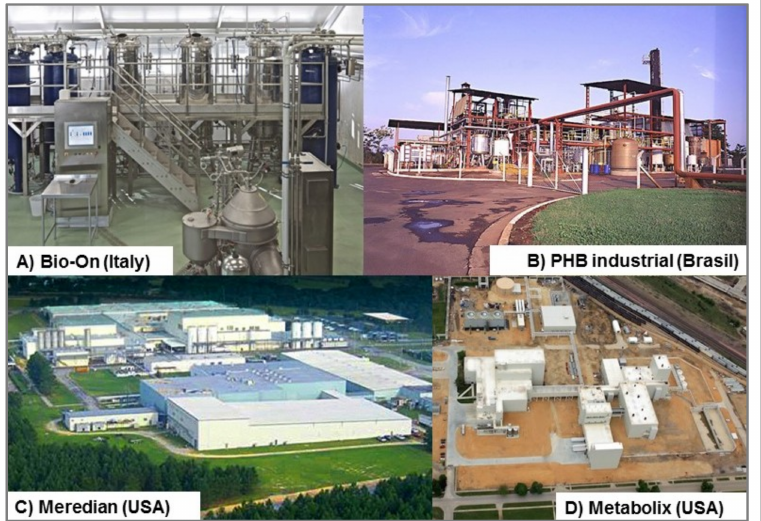
Figure 2. PHB production plants: ( A ) Bio-On in Italy that produces Minerva; ( B ) PHB industrial in Brazil that produces Biocycle; ( C ) Meredian in the USA; ( D ) Metabolix in the